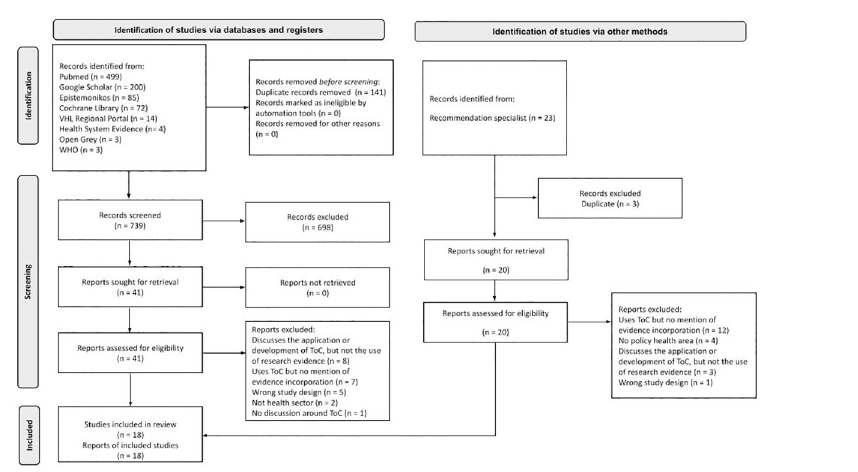
Fig 1. Example of Theory of Change framework. Source: De Silva et al., 2014, p.4 [13].